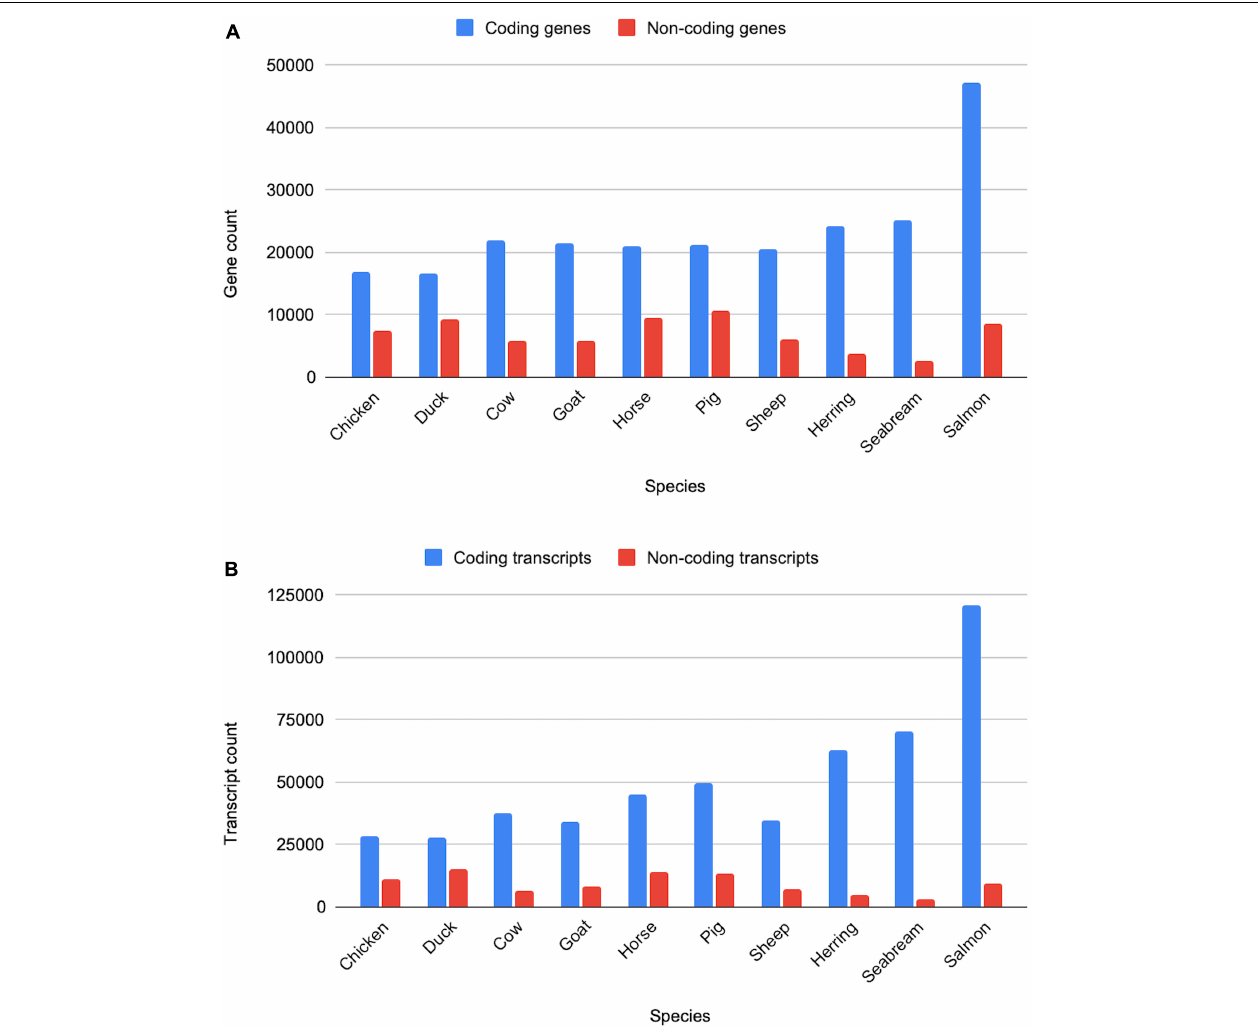
FIGURE 10 | Counts of coding and non-coding genes and transcripts for ten livestock species. Panel (A) shows the gene counts, while panel (B) shows the transcripts counts for various livestock species from the bird, mammal and fish clades.